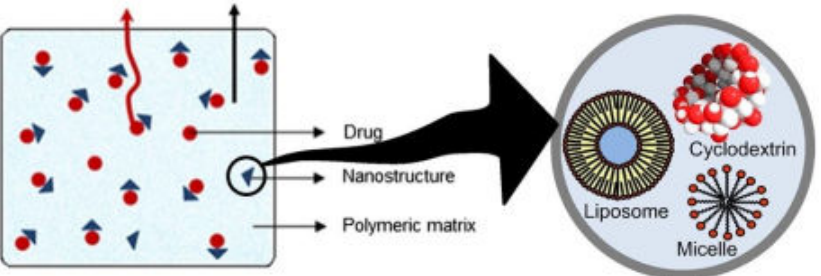
Figure 6. Drug release from a CL loaded with nanostructures. Reproduced with permission from [53], @Copyright 2015,